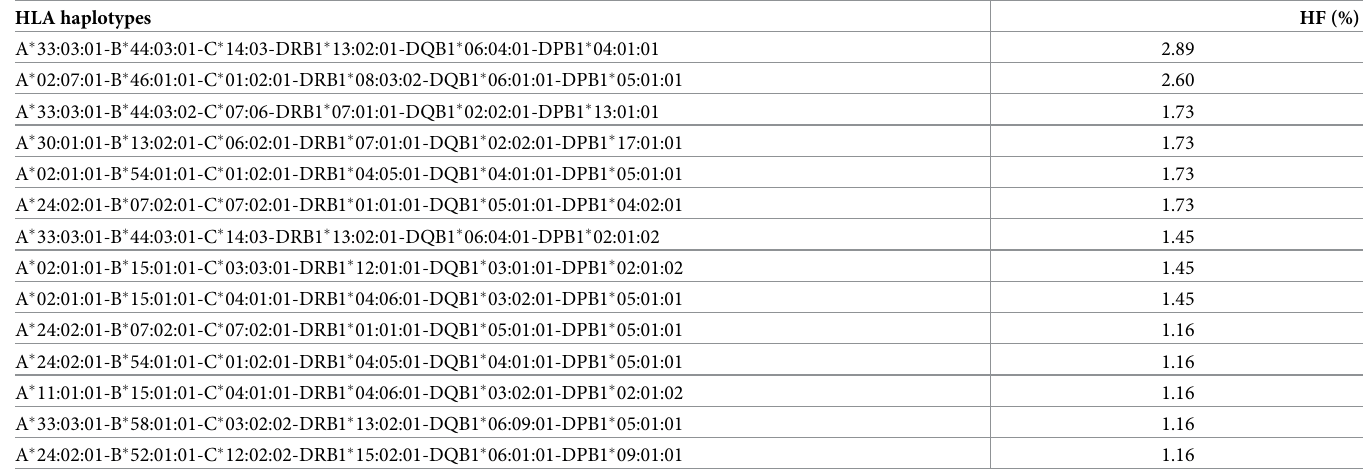
Table 2. Haplotype frequencies of HLA-A, -B, -C, -DRB1, -DQB1, and -DPB1 ( > 1%). HLA